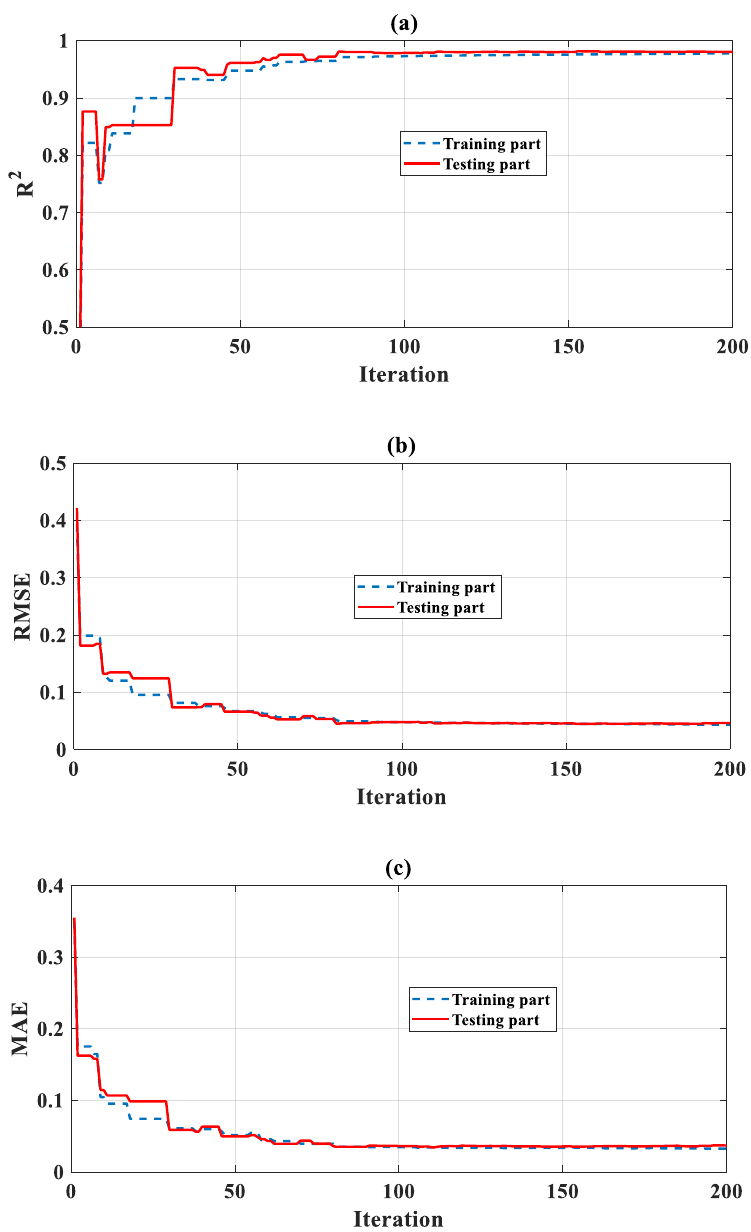
Figure 6. Optimization of weight parameters of ANN models using the TLBO algorithm: ( a ) R 2 , ( b ) RMSE, and ( c ) MAE.